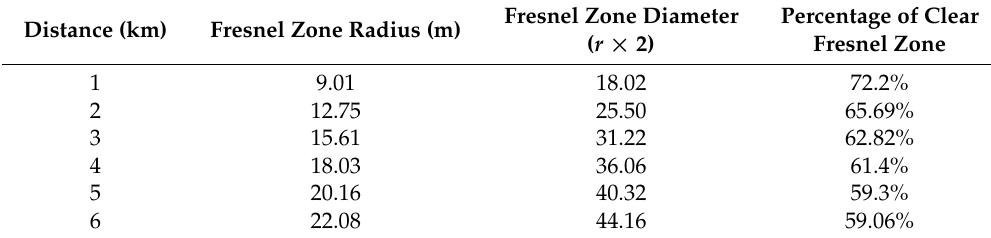
Table 8. Fresnel zone calculations for the measured